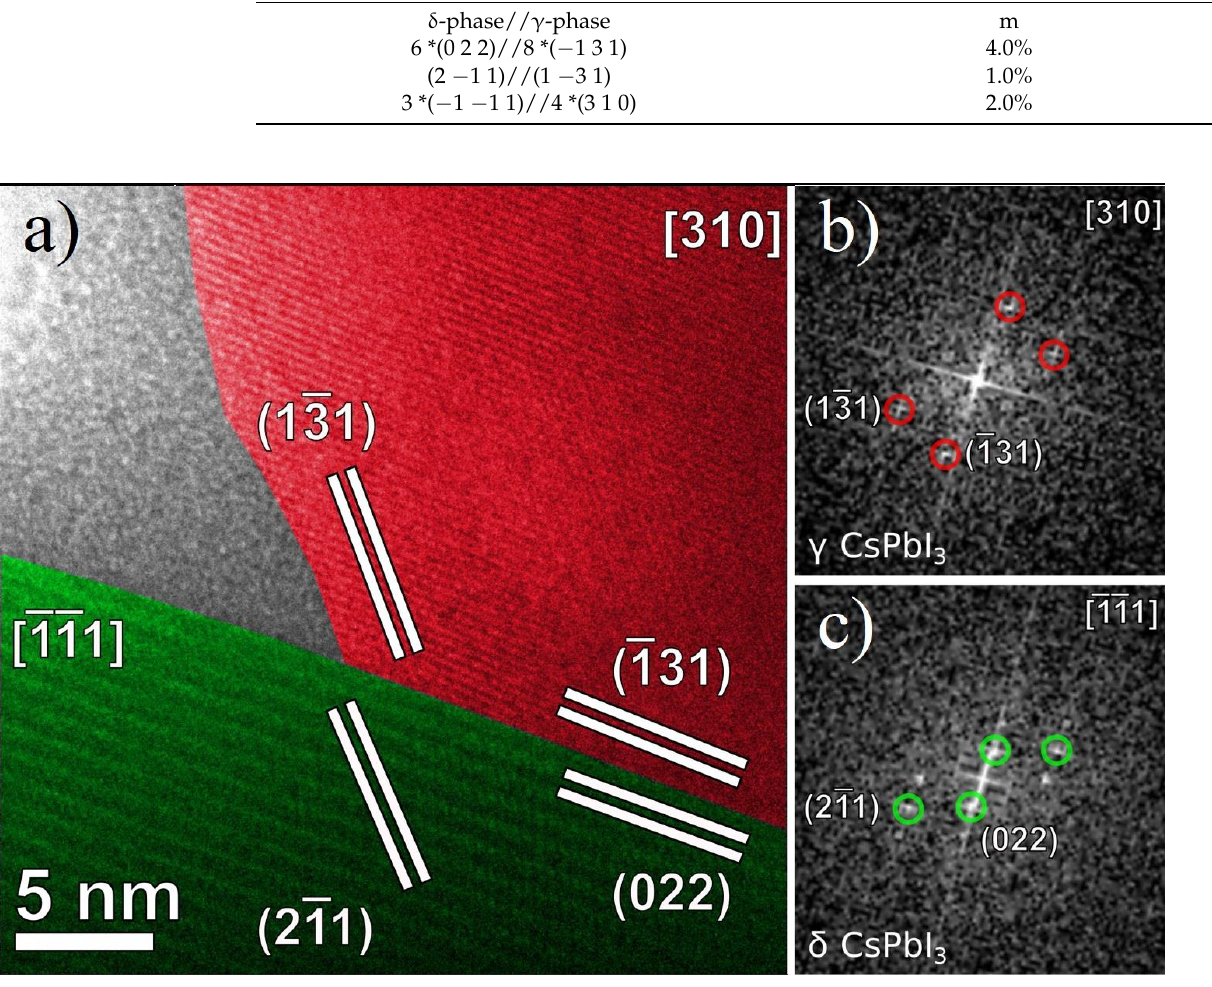
Figure 11. ( a ) Epitaxy study on the interface between γ-CsPbI3 and δ-CsPbI3, previously reported in Figure 10. γ-CsPbI3 and δ-CsPbI3 crystal domains in the HRTEM image are depicted in red and green, respectively. ( b , c ) The diffraction spots in the 2D-FFT diffractograms corresponding to the lattice planes used for the mismatch calculations are indicated according to the same color coding.